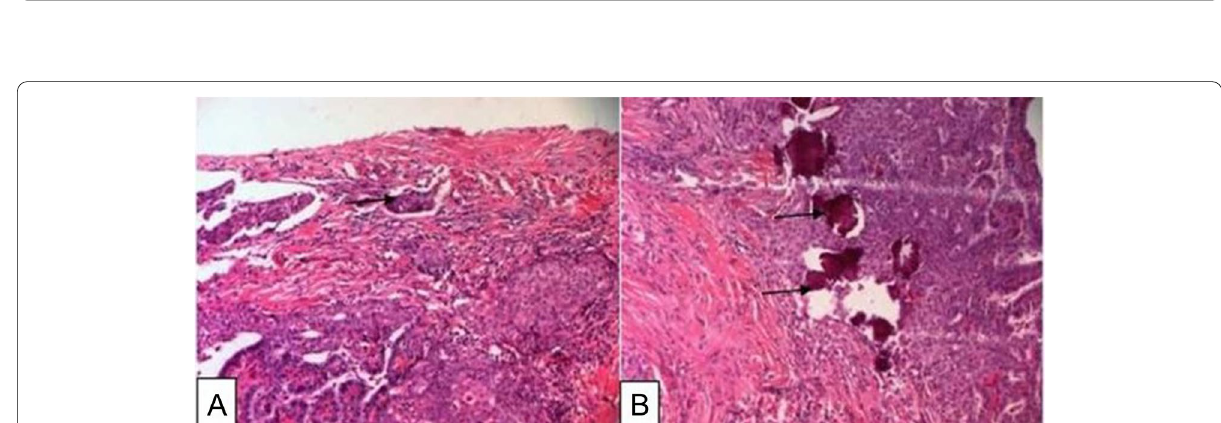
Fig. 3 Microscopic features of tumor stroma. A Diffuse severe hyaline fibrosis (HE sheets (HE 50) ×